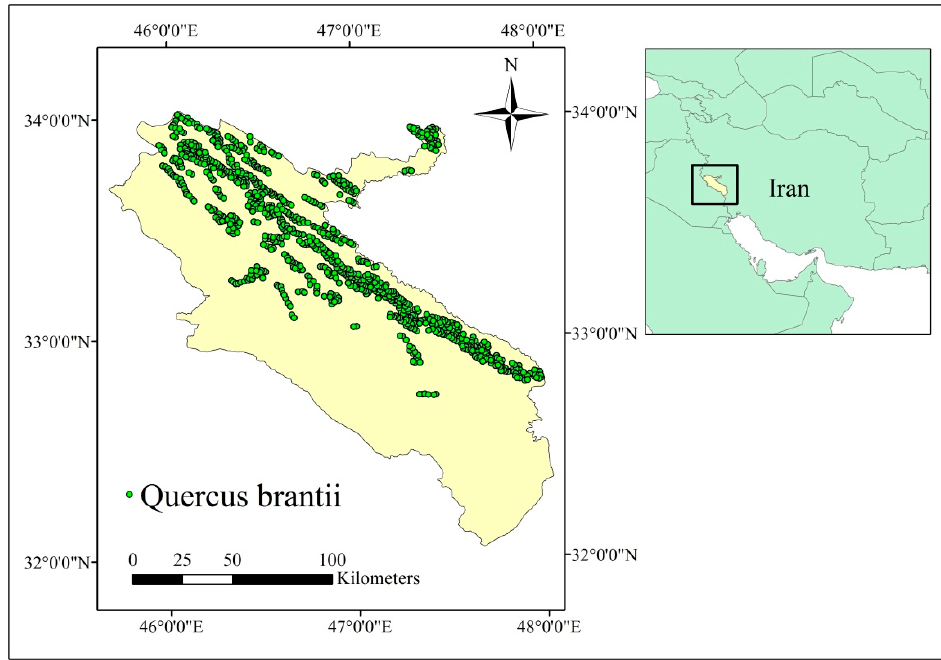
Figure 1. The study area in the west of Iran (www.rsgisc.com accessed date 10 October 2022).